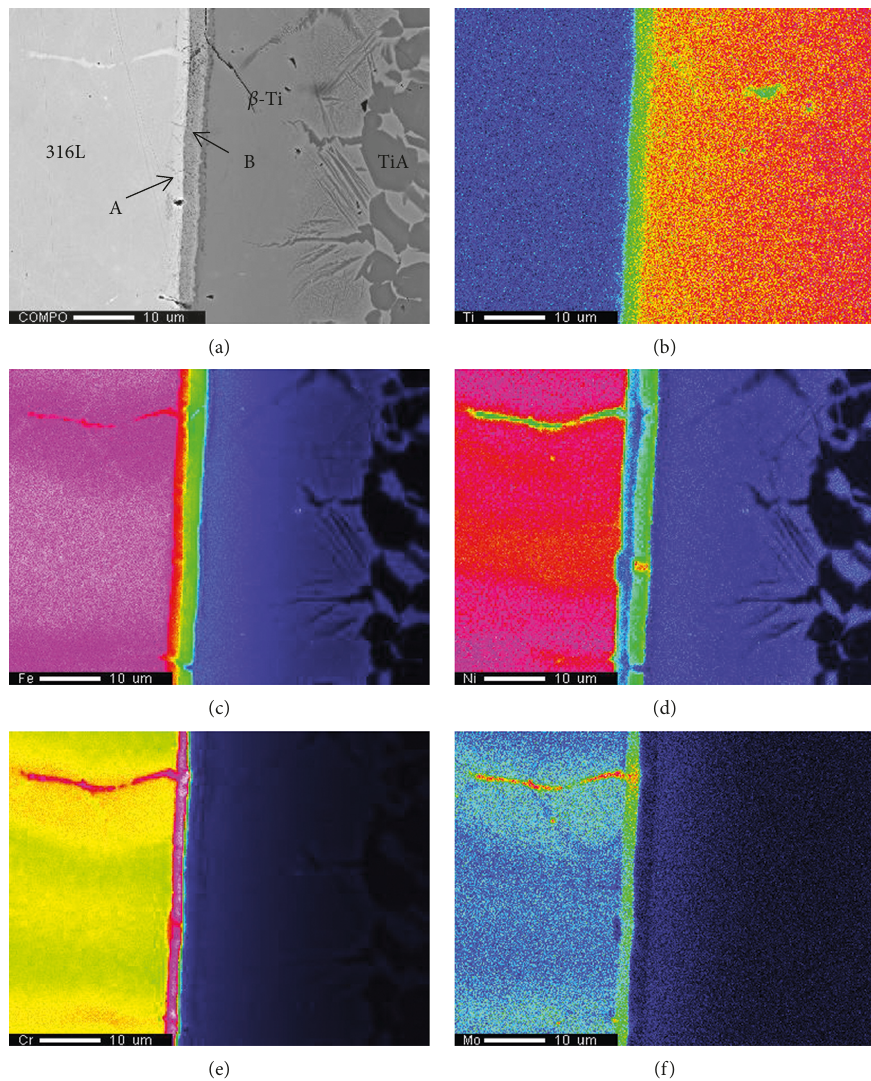
Figure 2: Concentration profiles from EPMA analysis of elements Ti, Fe, Ni, Cr, and Mo along with a BSE image of a region at Ti-6Al-4V and 316L stainless steel joint interface bonded at 900 ° C: (a) BSE image; (b) Ti map; (c) Fe map; (d) Ni map; (e) Cr map; (f) Mo